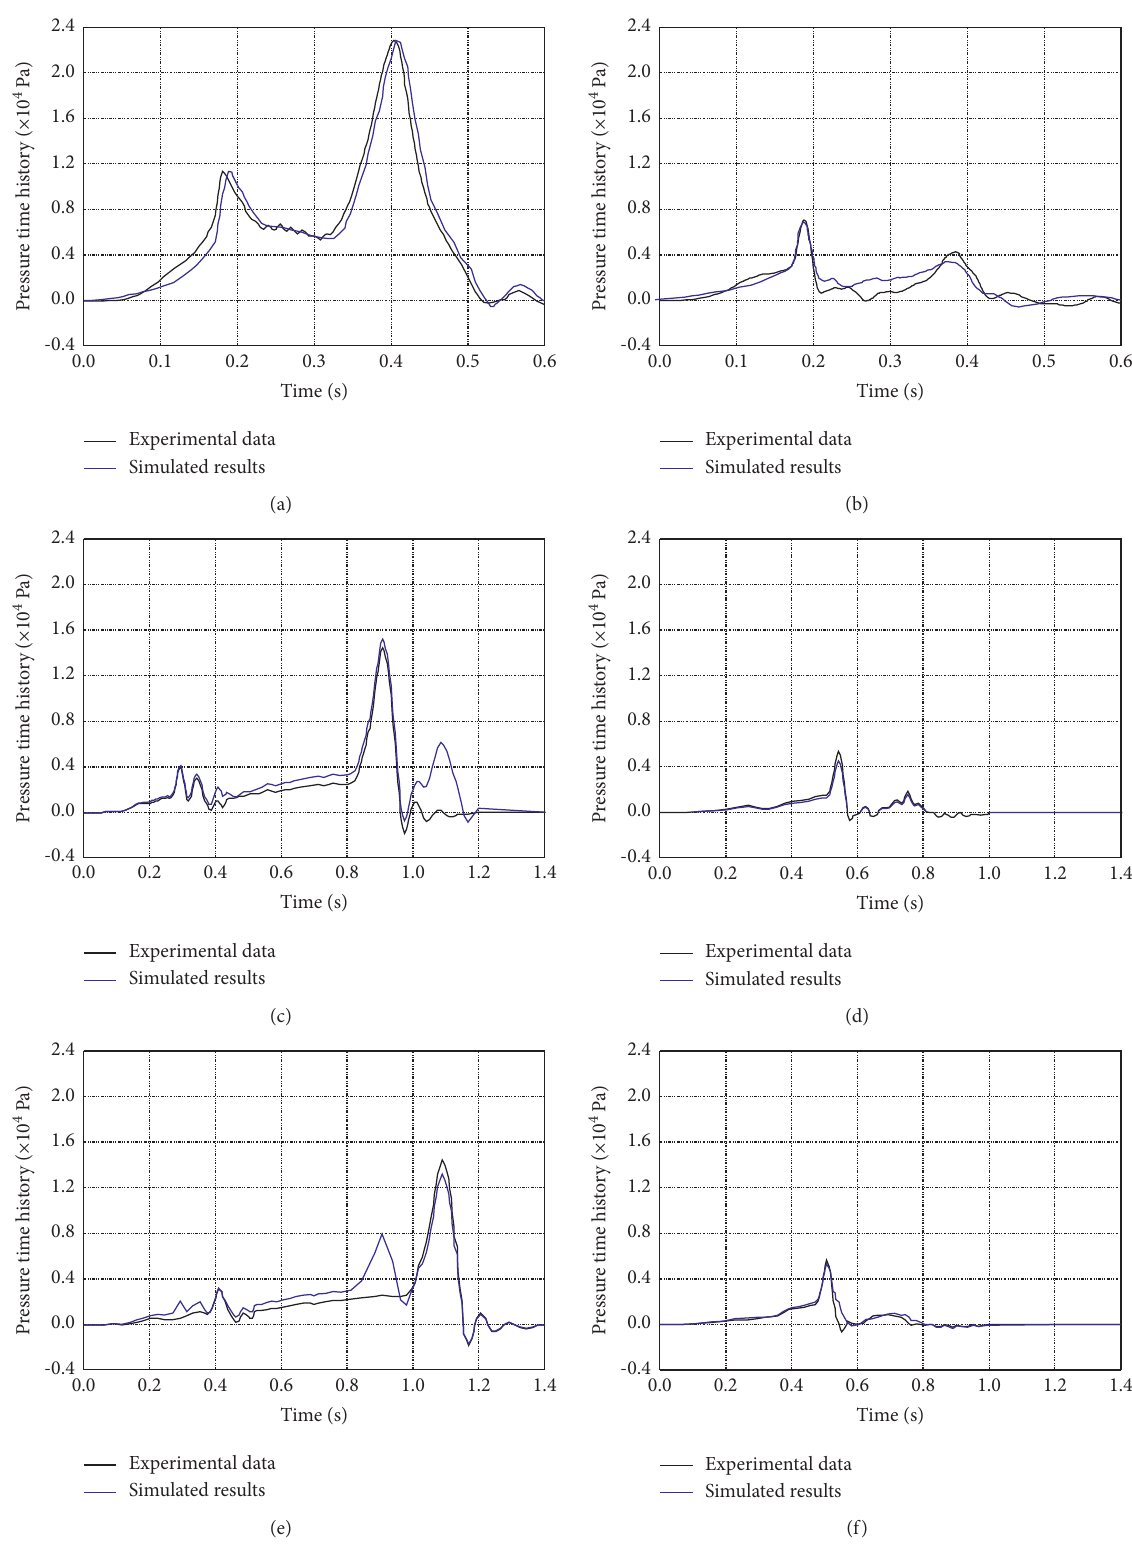
Figure 3: Pressure time histories from experimental data and simulated results. (a) Chamber I with a 2.7 m 2 vent (Hydrogen): IP1 (b) Chamber II with a 5.4 m 2 vent (Hydrogen): IP2. (c) Chamber I with a 2.7 m 2 vent (Methane): IP1 (d) Chamber II with a 5.4 m 2 vent (Methane): IP2. (e) Chamber I with a 2.7 m 2 vent (Propane): IP1 (f) Chamber II with a 5.4 m 2 vent (Propane):